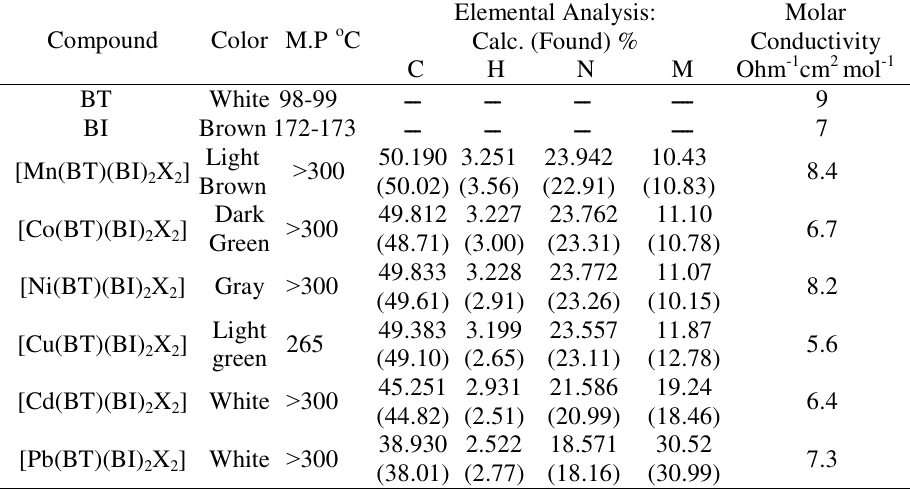
Table 1. Physical properties, conductivity and analytical data of the free ligands and its